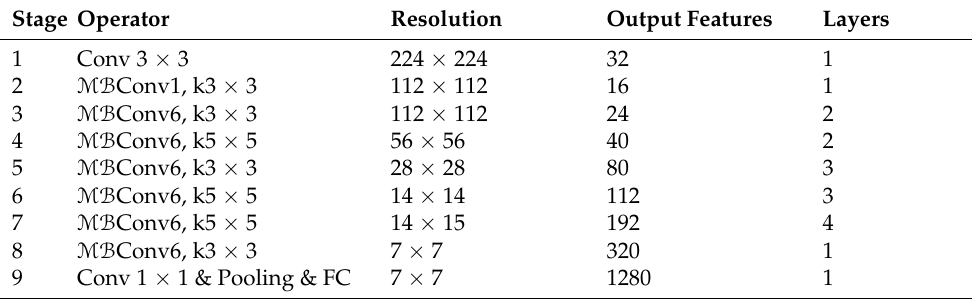
Table 1. Outline of the EfficientNet-B0 baseline network